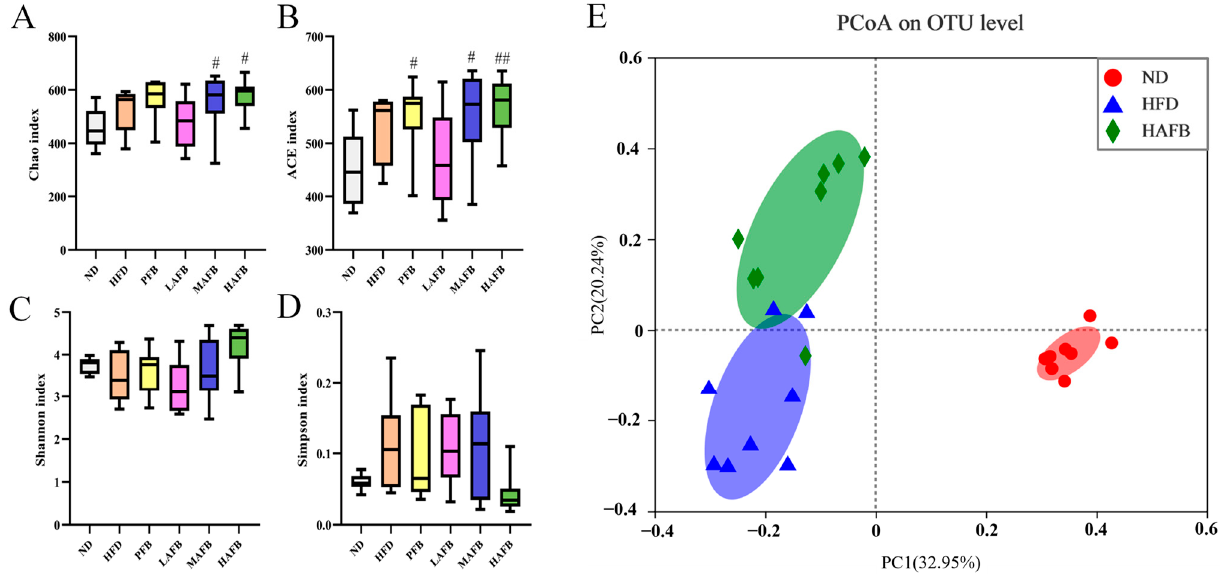
Figure 4. AFB affected the α and β diversity of the mouse gut microbiota. ( A ) Chao index, ( B ) ACE index, ( C ) Shannon index, ( D ) Simpson index, and ( E ) UniFrac distance-based principal coordinate analysis (PCoA) of the ND, HFD, and HAFB groups. # p < 0.05, ## p < 0.01 versus the ND group by one-way ANOVA.